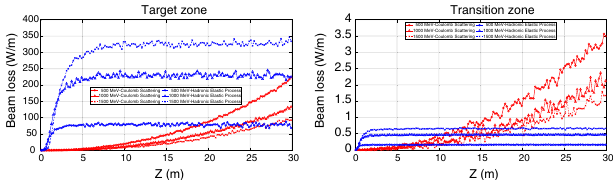
FIG. 16. Beam loss caused by gas scattering in transition and target